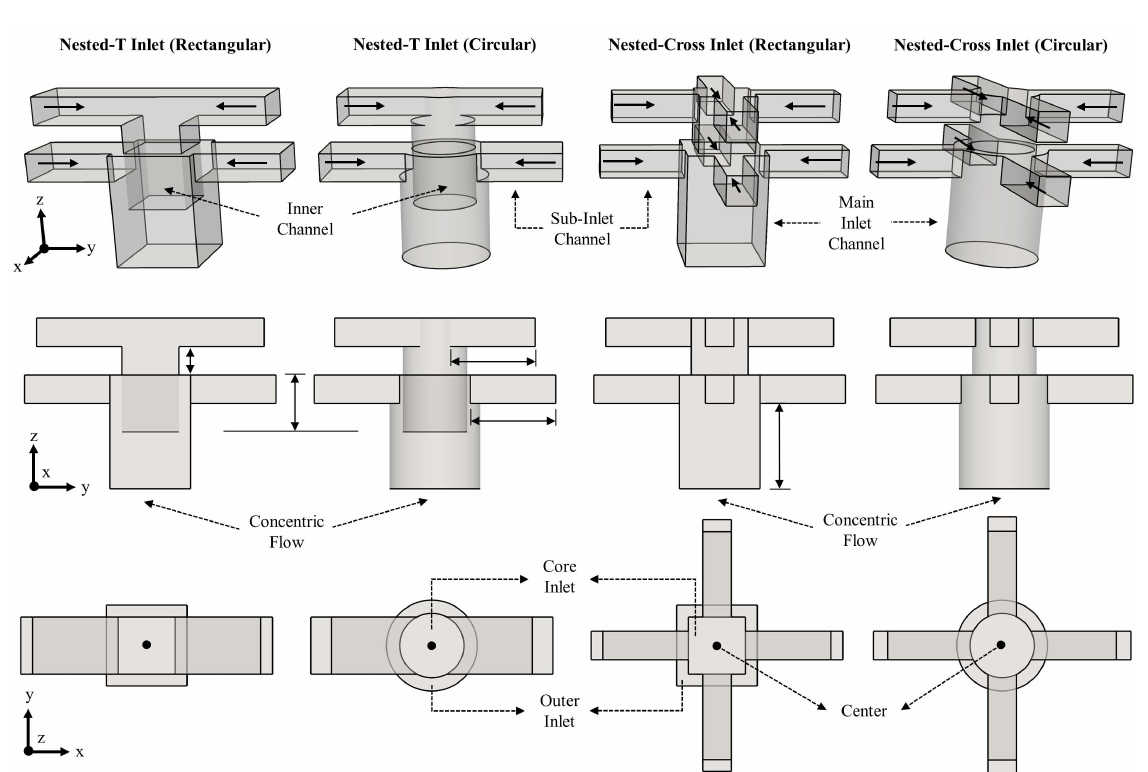
Figure A1. Nested-T ( left two columns ) and nested-cross ( right two columns ) inlet structures to create concentric fluid flow in circular and rectangular microchannels. 3-D view ( top ), yz-plane ( middle ), and xy-plane ( bottom ).